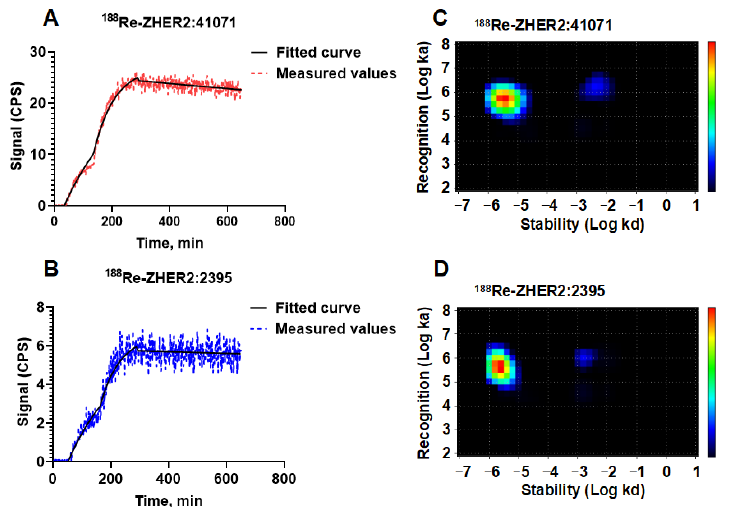
Figure 1. In vitro binding specificity of 188 Re-ZHER2:41071 to HER2-expressing SKOV-3 ( A ) and SKBR-3 ( B ) cells. For pre-saturation of HER2, a 500-fold molar excess of non-radiolabeled polypep- tide was added. The data are presented as an average ( n = 3) value ± SD.